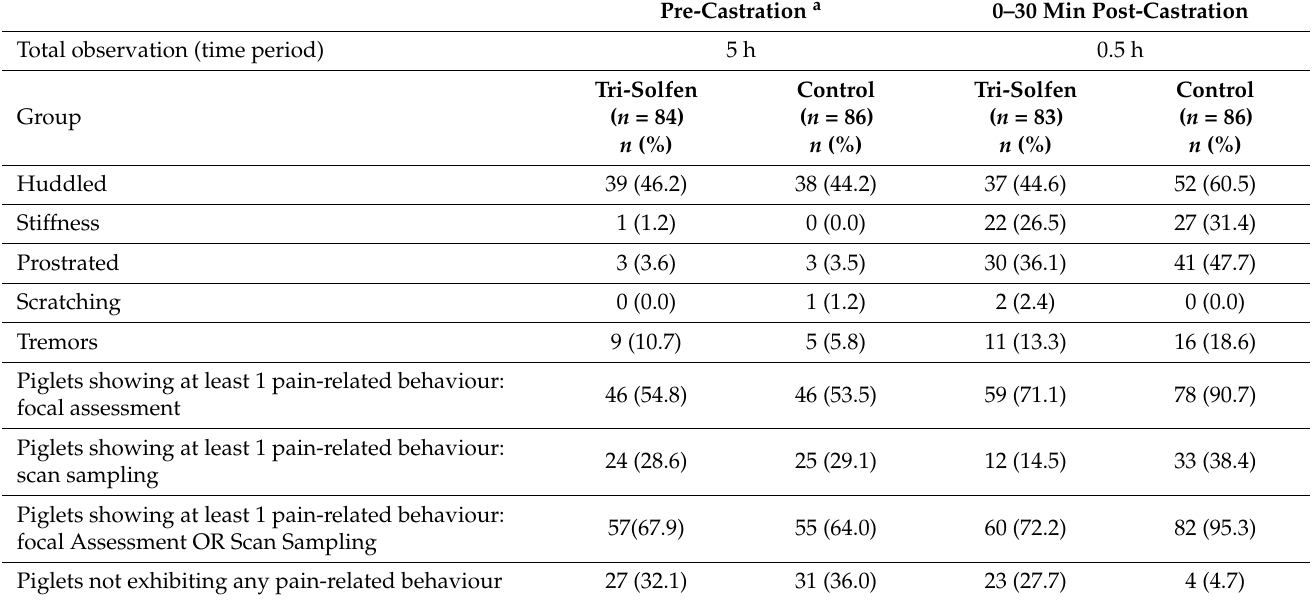
Table 4. Number of piglets showing specific pain-related behaviours pre-castration over a total 5 h observation period and 0–30 min